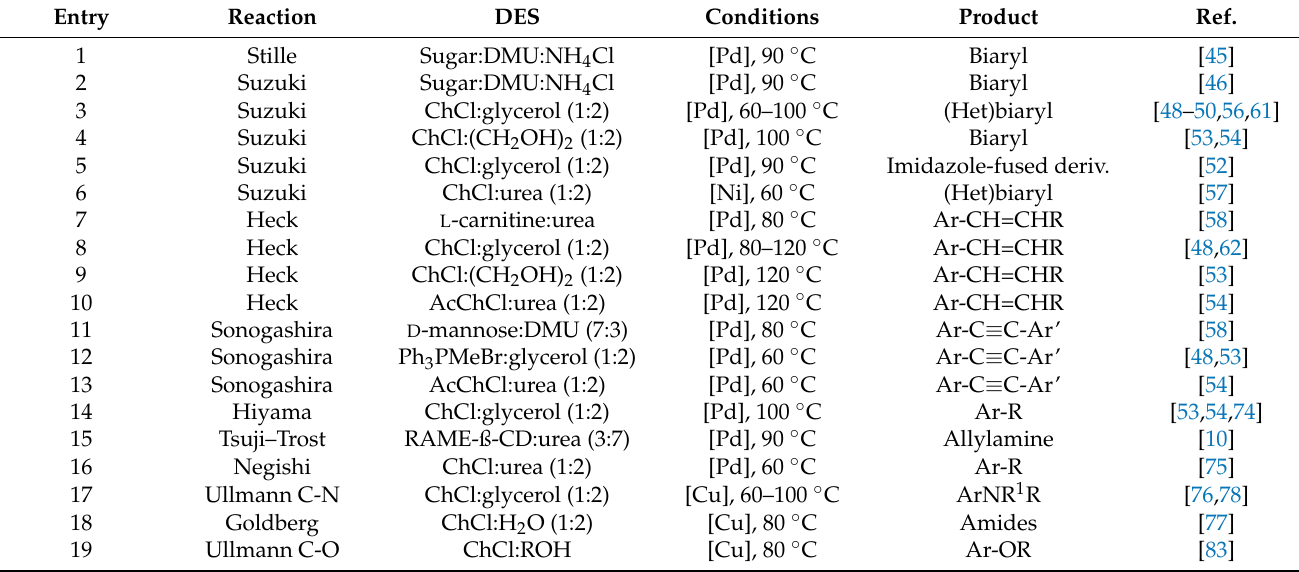
Table 3. Selected examples of cross-coupling reactions catalyzed by transition metals in DESs.